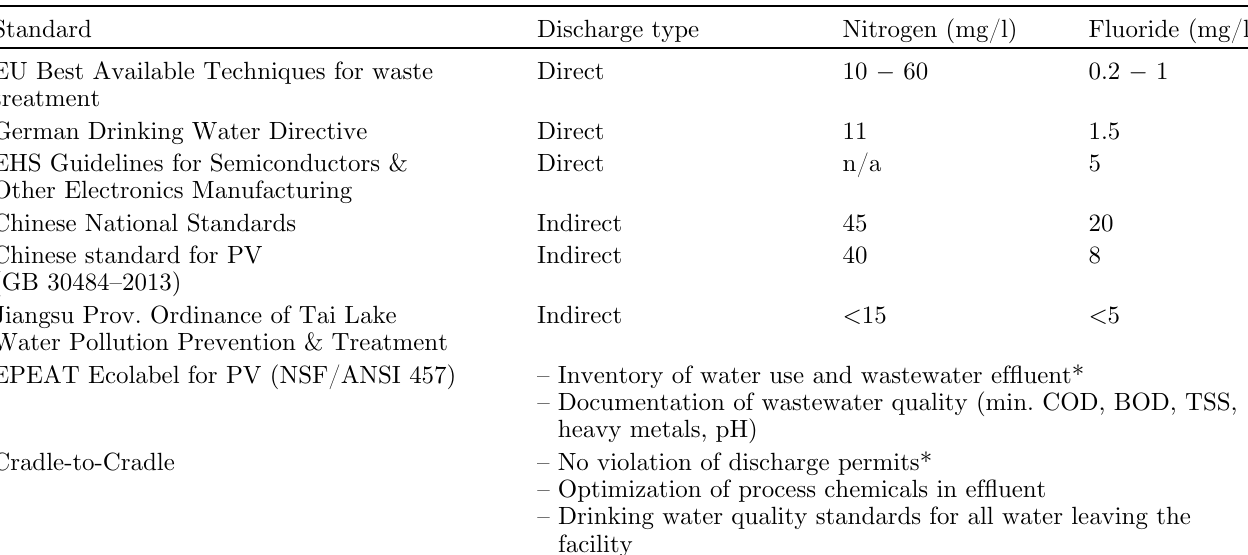
Table 2. Overview of standards regulating ef fl uent